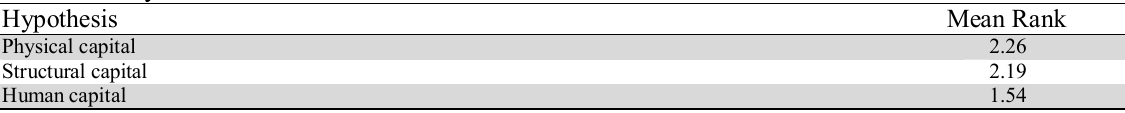
The summary of Freedman test Hypothesis Mean Rank